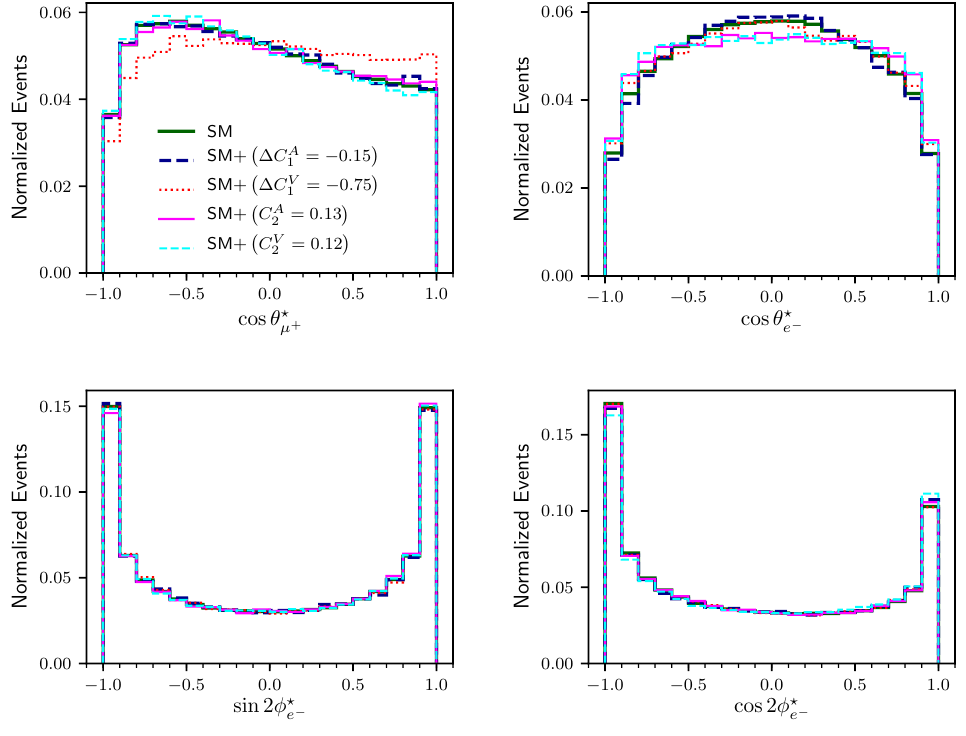
in left-top , p Z in z z